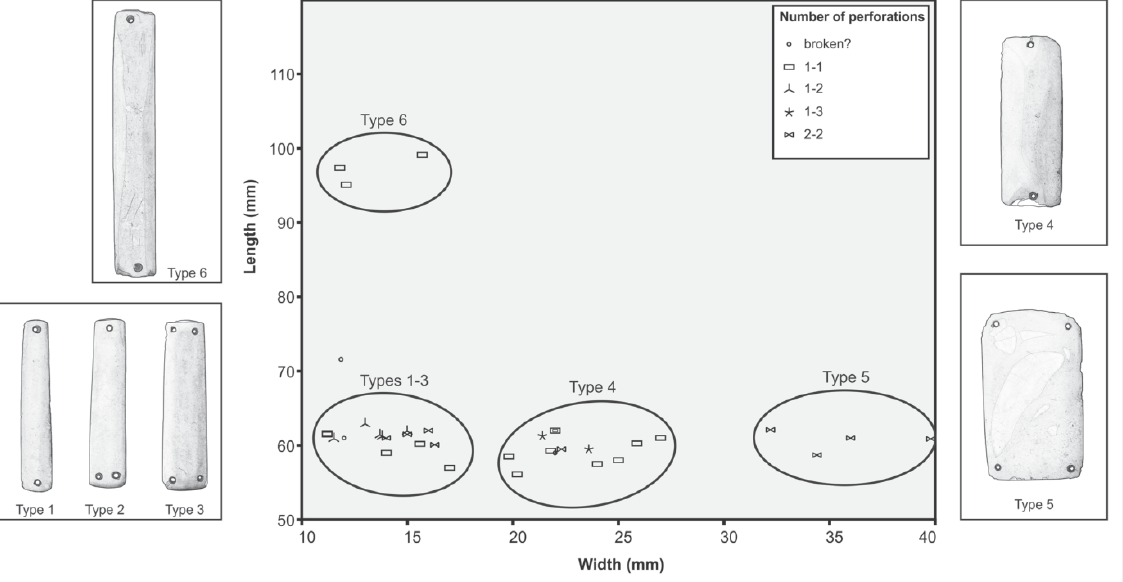
Figure 10. Typology of the rectangular links from Arpachiyah (source Stuart